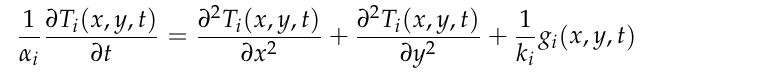
Figure 2. Flowchart of the solution procedure for the SSM.